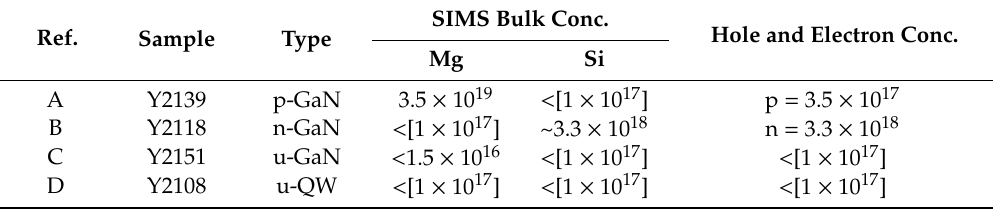
Table 1. Doping information of the samples: From the electron concentration of the n-doped samples from Hall measurements, we estimated the Si concentration, whereas both Mg and hole concentrations were measured (independently) for the Mg-doped samples using dynamic SIMS (secondary-ion mass spectrometry) and Hall measurements. Conc. In brackets means assumed concentration per cm 3 . p-GaN: p-type GaN, n-GaN: n-type GaN, u-GaN: un-doped GaN, un-doped GaN-GaInN (gallium indium nitride)-GaN quantum well structure.